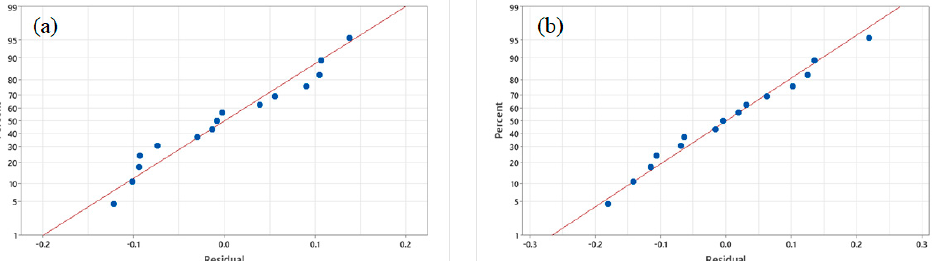
Figure 3. The plots of normal probability of residuals for the extraction yield ( a ) and peroxide value ( b ).